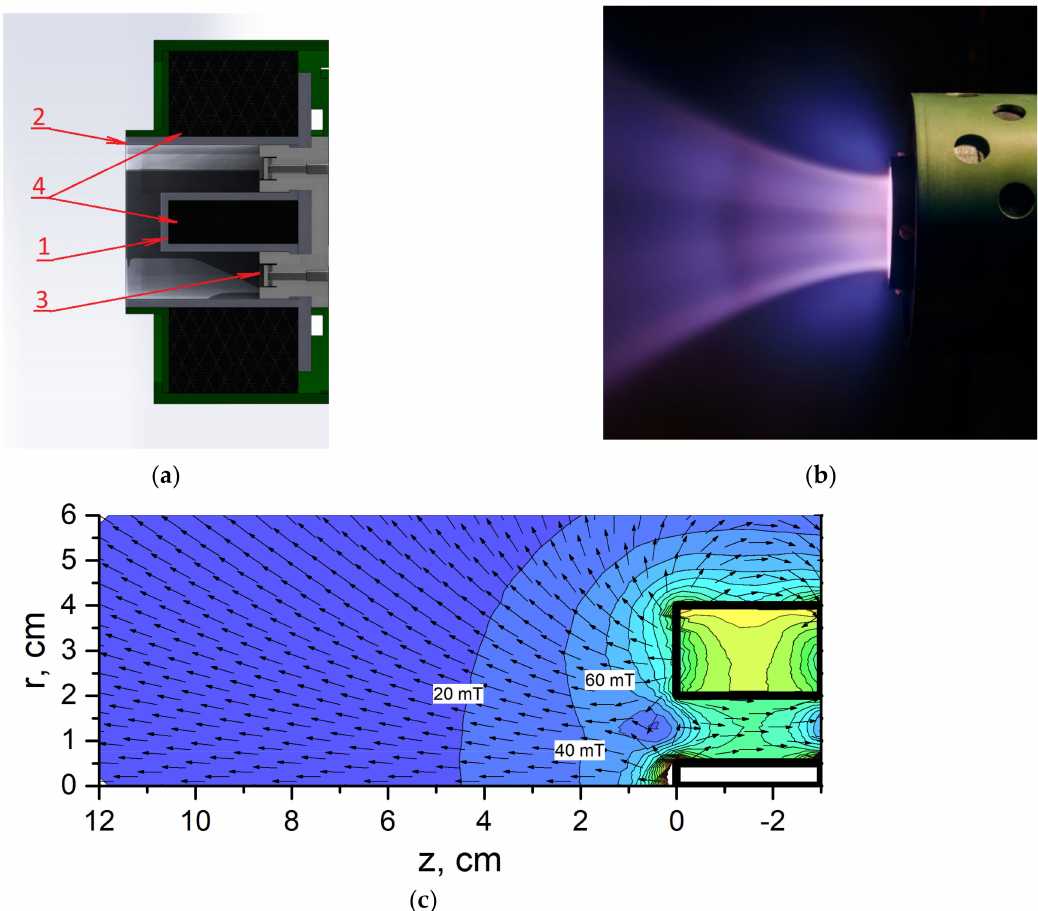
Figure 1. ( a ) C-STAR principal design, ( b ) plasma appearance, and ( c ) simulation of magnetic